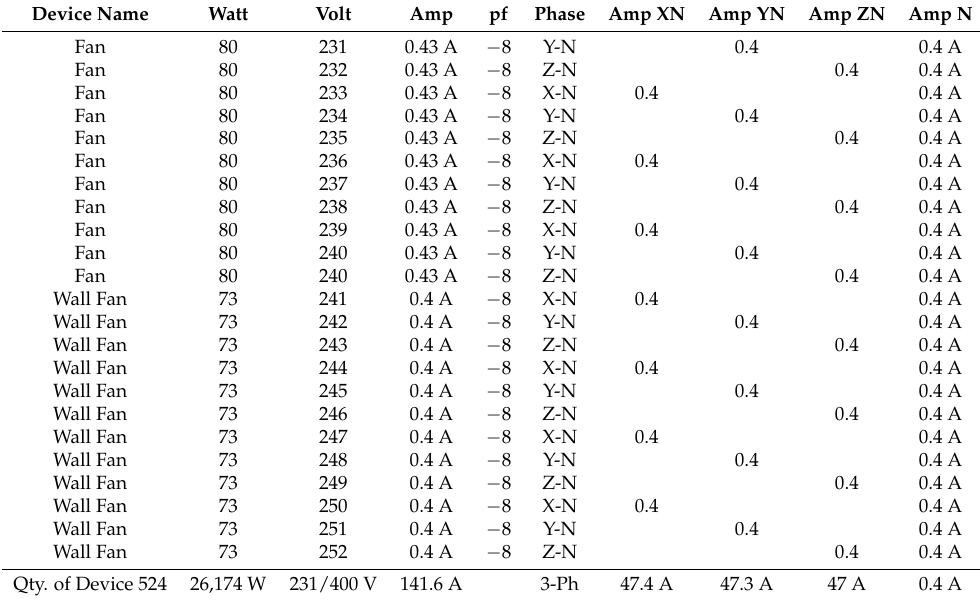
Table 12. Academic Block proposed load